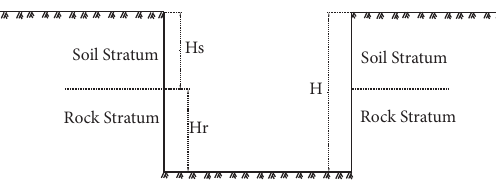
Figure 4: Analysis model of deep foundation Table 1: The physical and mechanical parameters.